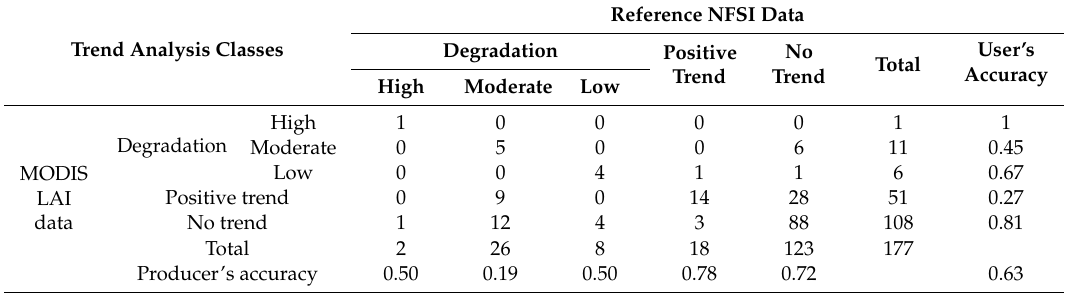
Table 3. Confusion matrix of the trend analysis of the MODIS LAI data and the reference